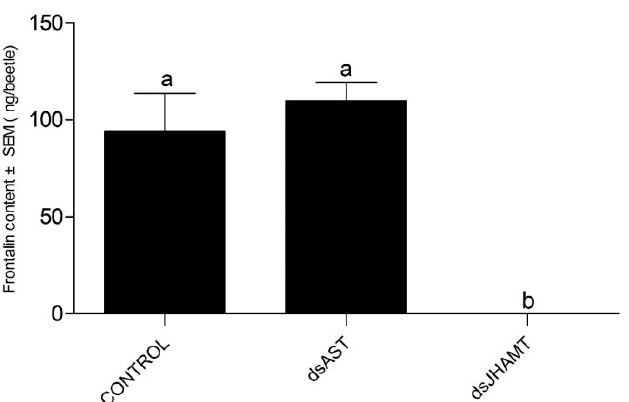
Figure 10. Knockdown of DaAST and DaJHAMT affected frontalin biosynthesis. Frontalin levels in male adults injected with dsRNA for the DaAST and DaJHAMT genes. Different letters above the bars indicate a significant difference (one-way ANOVA, p < 0.05, with Tukey’s test for multiple